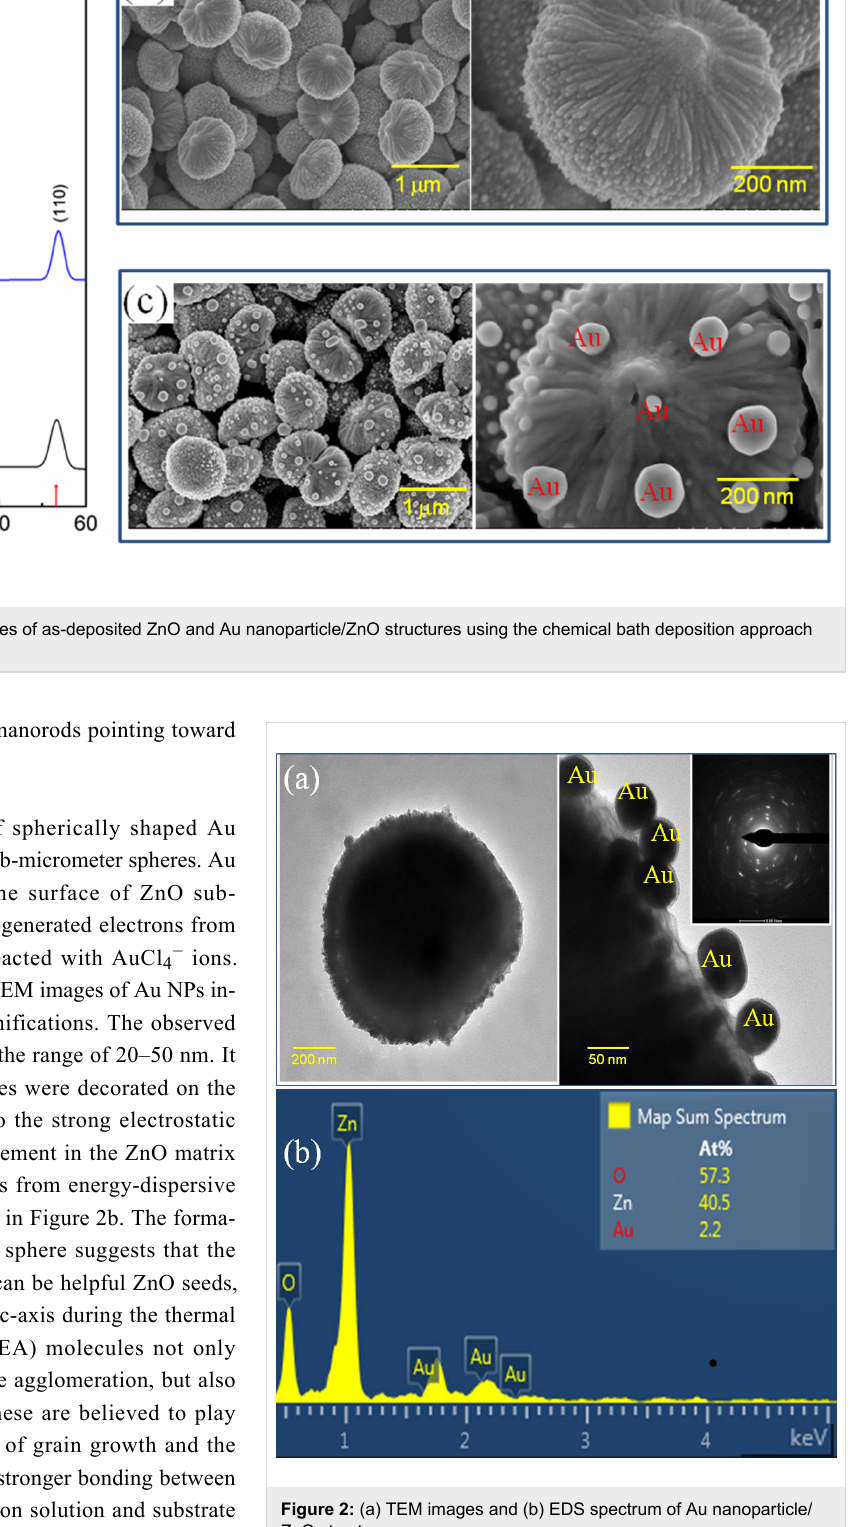
Figure 2: (a) TEM images and (b) EDS spectrum of Au nanoparticle/ ZnO